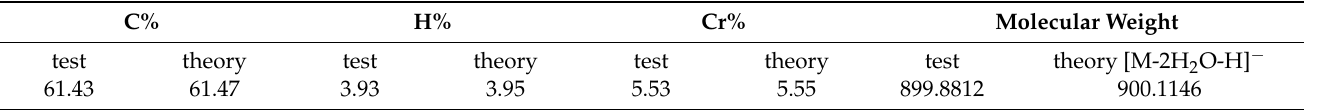
Table 1. Elemental and MS analysis of the